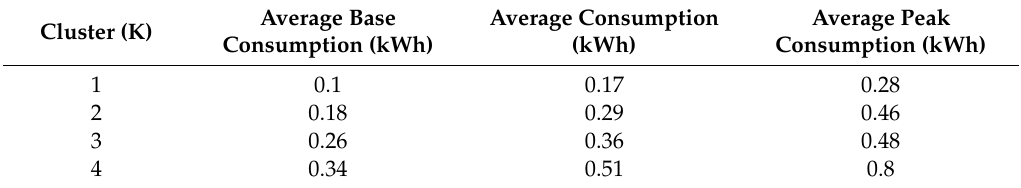
Table 2. Annual average base consumption (kWh), average consumption (kWh), and average peak consumption (kWh) of the four